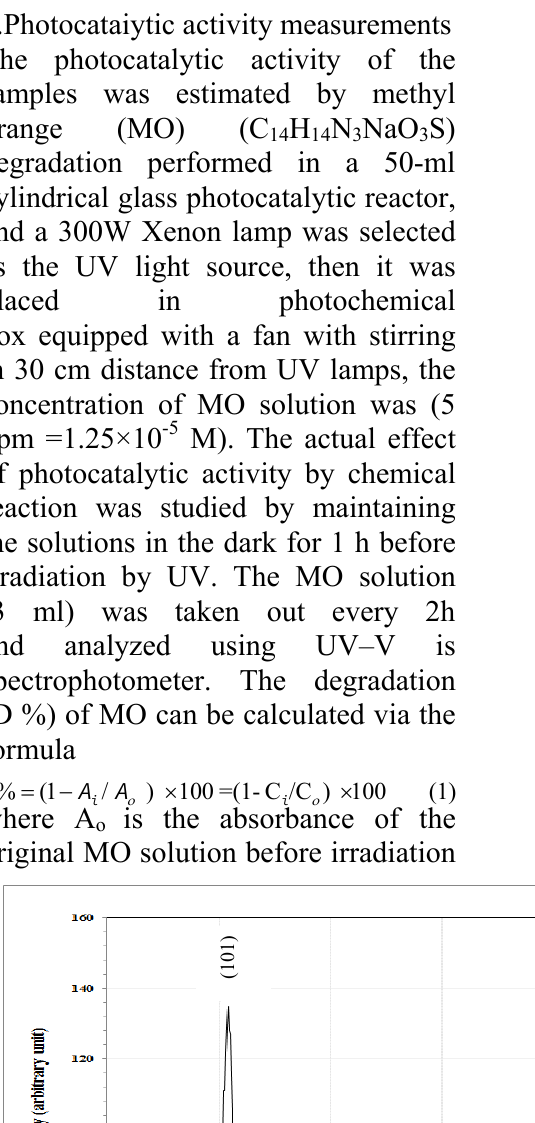
nnorods prepared by sol gel template method and annealed at 2 500°C for